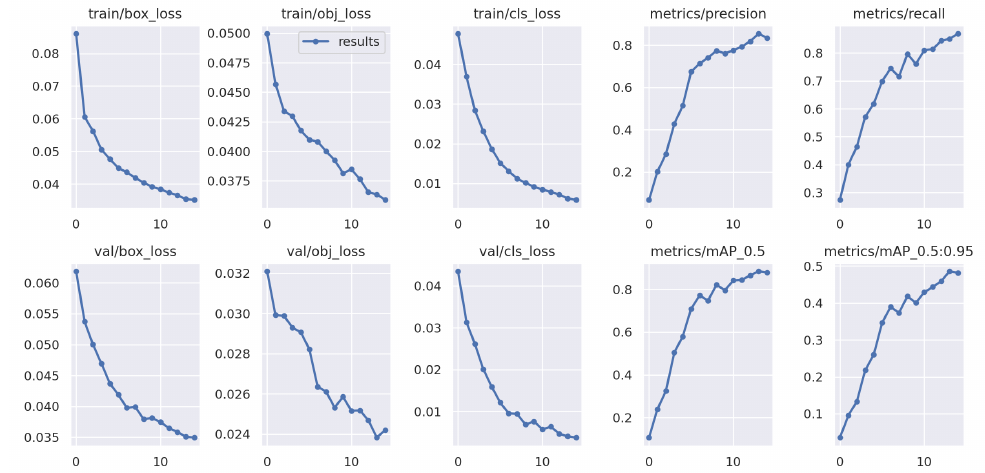
Figure 7. Distinct forms of loss functions and performance metrics, that include boxloss, objectloss, precision, recall and mAP.